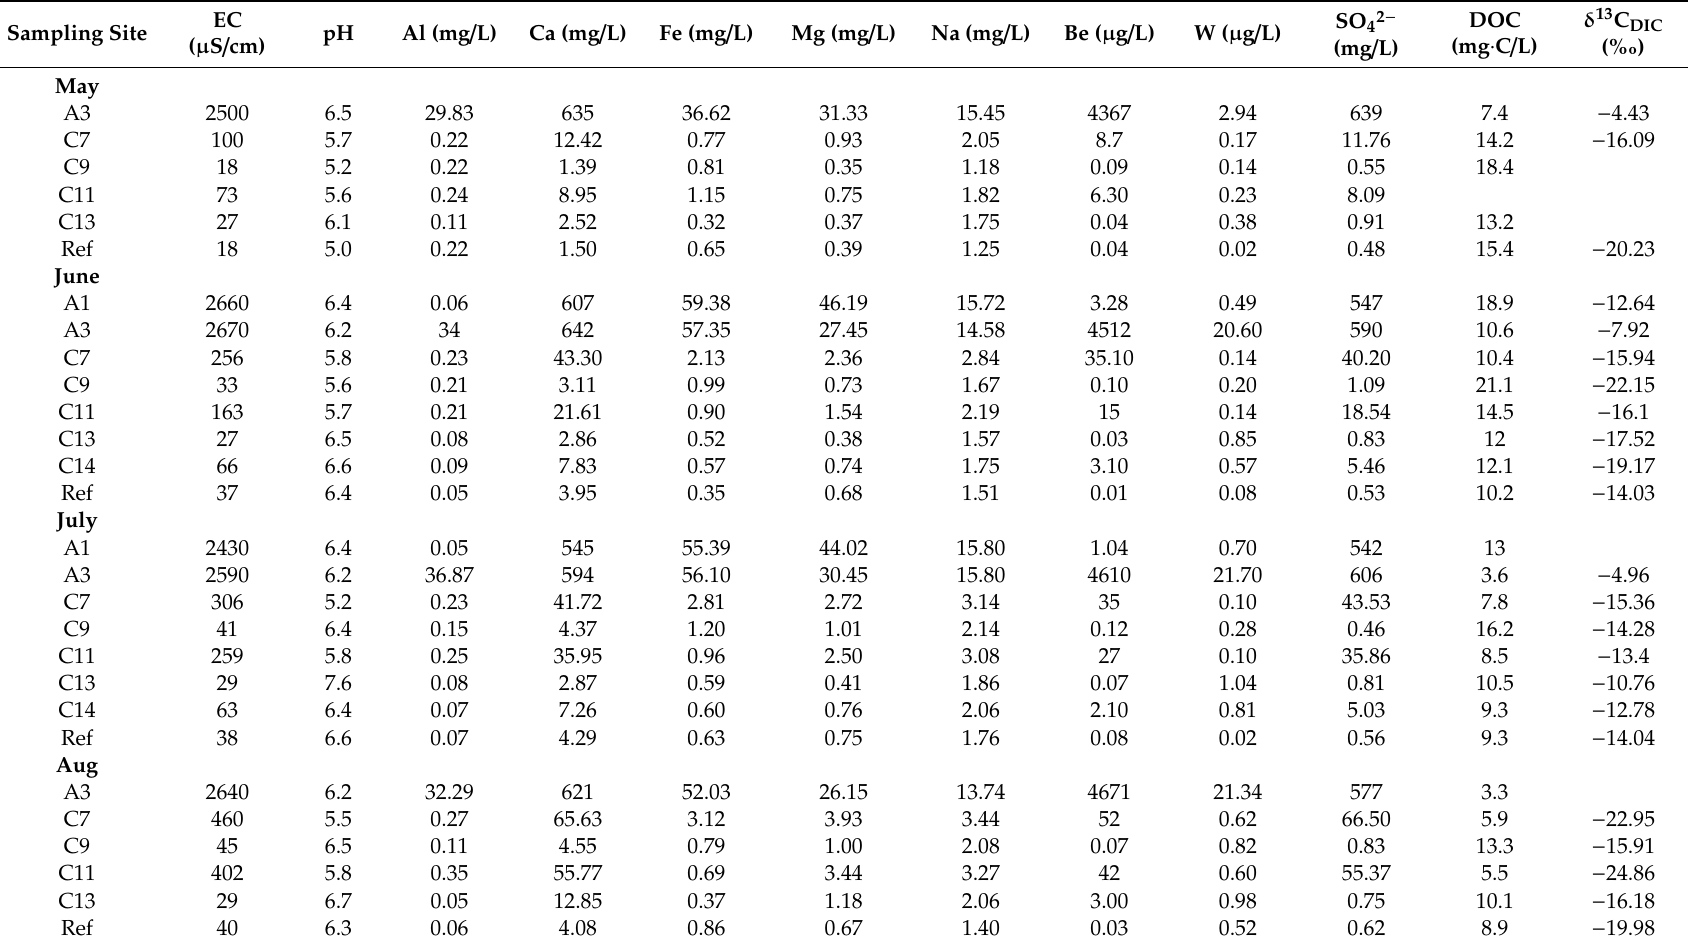
Table 2. Physicochemical, hydrochemical and isotopic data of ground and surface water samples. All data, except those for dissolved organic carbon (DOC) and the chemical and isotopic composition of primary calcite and dissolved inorganic carbon ( δ 13 C DIC ), are from [15,25]. Sampling